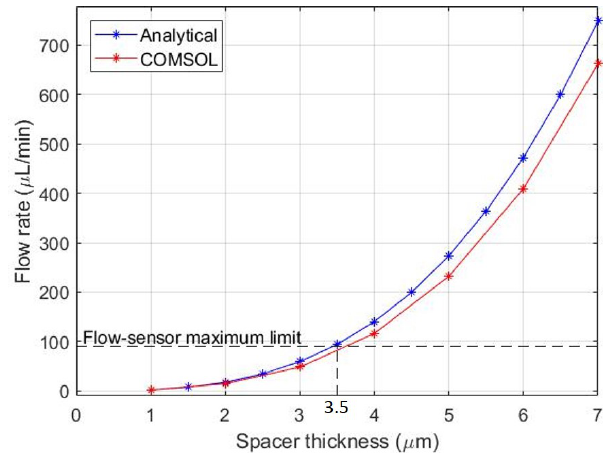
Figure 3. Flow rate dependence on spacer thickness with a 1000mbar pressure